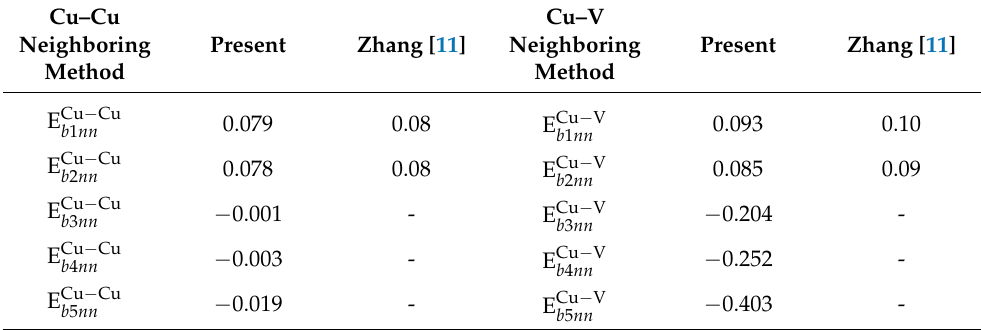
Table 1. Binding energy (eV) of Cu – Cu and Cu – V in different neighboring methods in BCC-Fe.